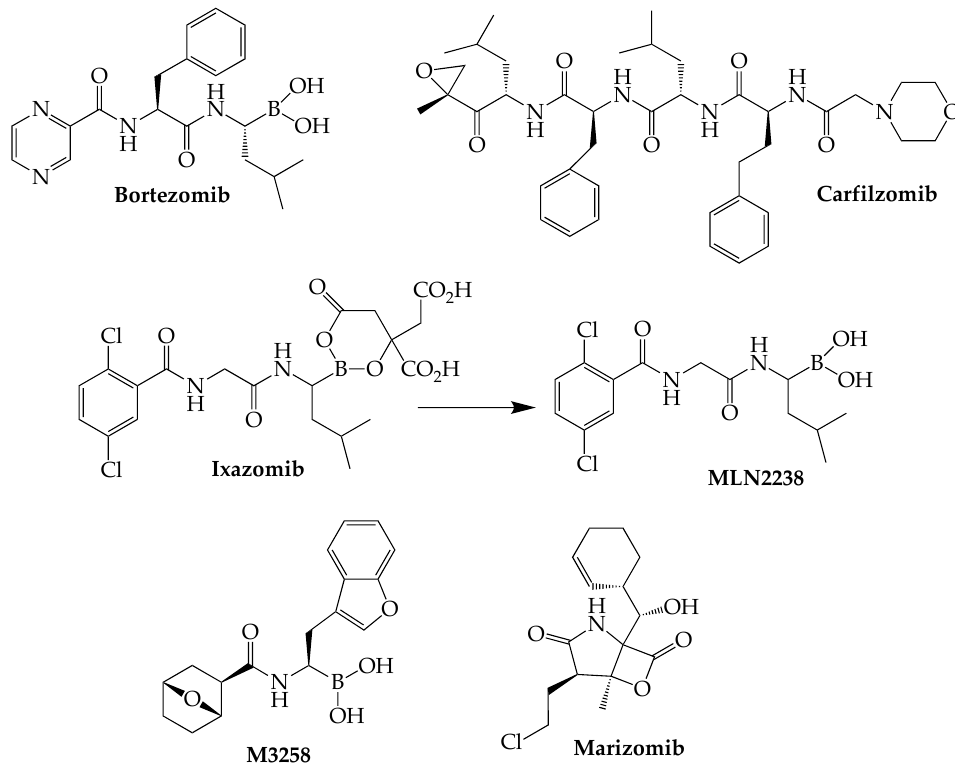
Figure 3. Structures of Proteasome Inhibitors Active Against MM.